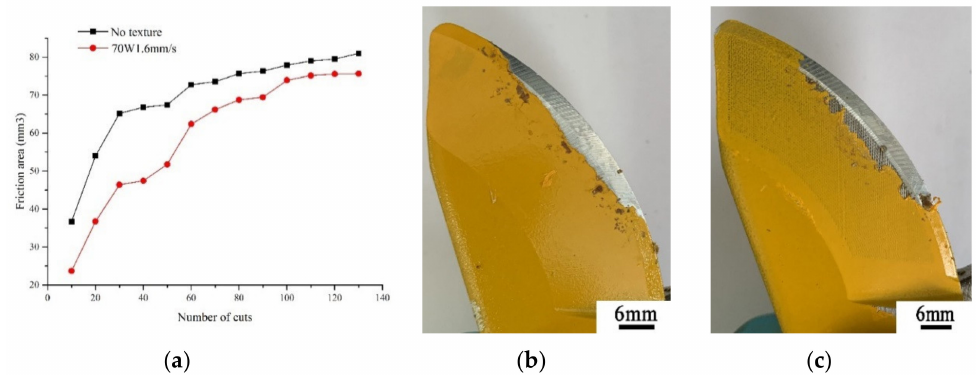
Figure 24. Shear test on the 10 mm-diameter branch: ( a ) relationship between worn area and number of cuts; painted worn area: ( b ) non-textured pruner, ( c ) textured pruner at the power of 70 W and speed of 1.6 mm / s.